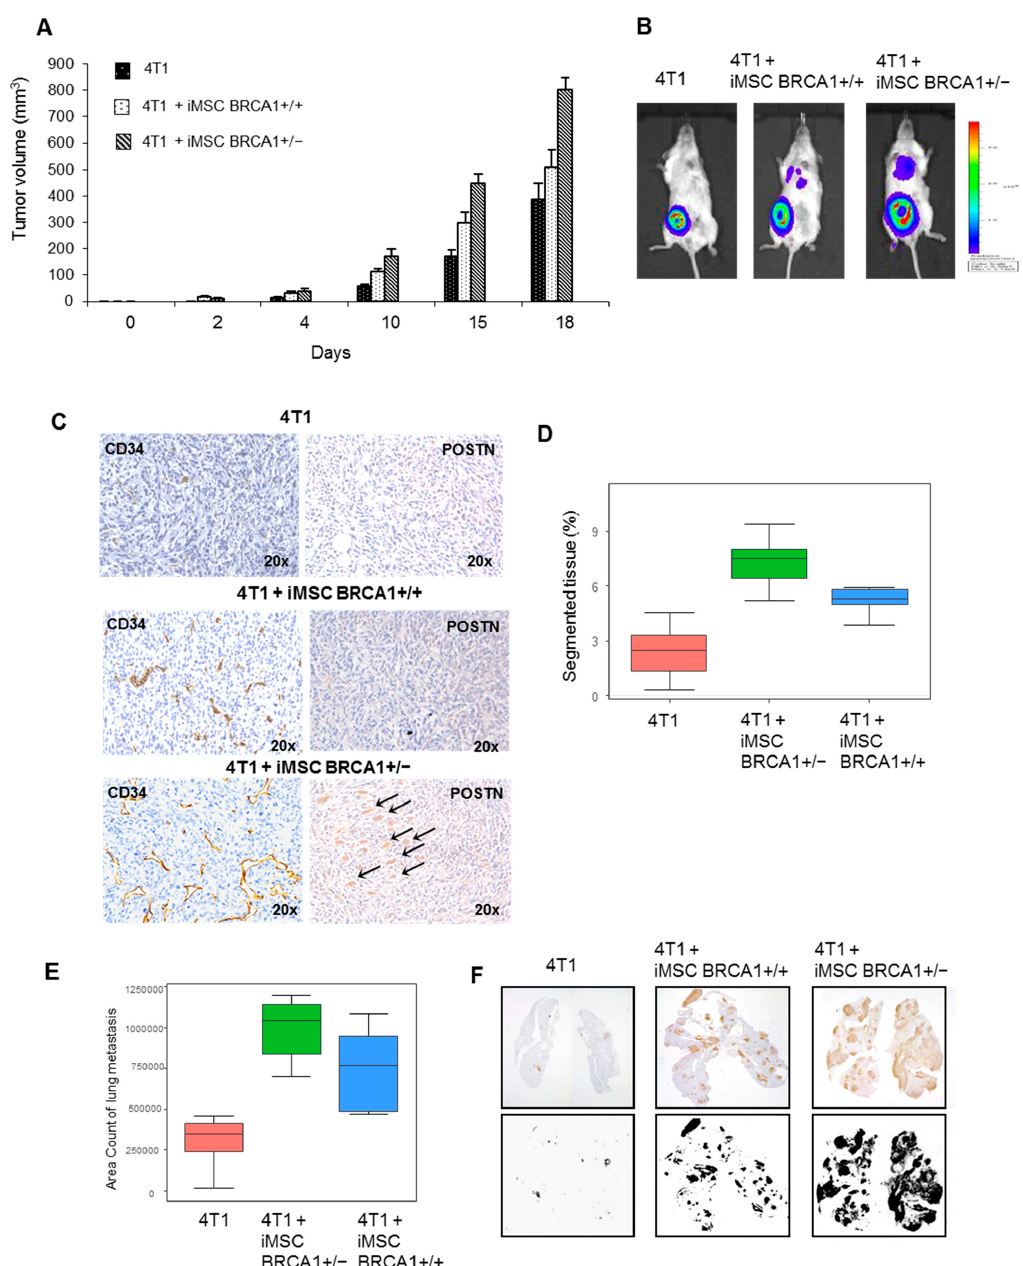
Figure 7. BRCA1 +/ − iMSCs enhance 4T1 tumor formation and lung metastasis. ( A ) To evaluate the in vivo tumorigenic potential of 4T1 cells, a total of 10 5 Luc-expressing 4T1 cells, either alone or premixed with 3 × 10 5 BRCA1 +/ − or BRCA1 +/+ iMSCs, were injected into the mammary fat pad. Tumor growth was recorded. Data are presented as the mean+SD. ( B ) Representative images of tumorigenesis visualized by bioluminescence imaging at day 18. ( C ) Left: CD34 immunostaining of tumor sections, showing a well-developed vessel network with a complete structure of new vessels within BRCA1 +/ − iMSC co-transplanted 4T1 tumors as compared with those co-injected with WT iMSC or only 4T1, right: immunohistochemistry of POSTN-immunoreactive material in tumor sections, showing cells positive for POSTN (arrows). ( D ) The extent of intratumoral vascularization was assessed by CD34 immunostaining and quantified by assessing the percentage of segmented tissue area that was positive for CD34 at day 18. ( E ) Quantification of lung metastatic areas at day 18. ( F ) The extent of lung metastasis is shown after 18 days within the whole lung area following immunohistochemical staining with